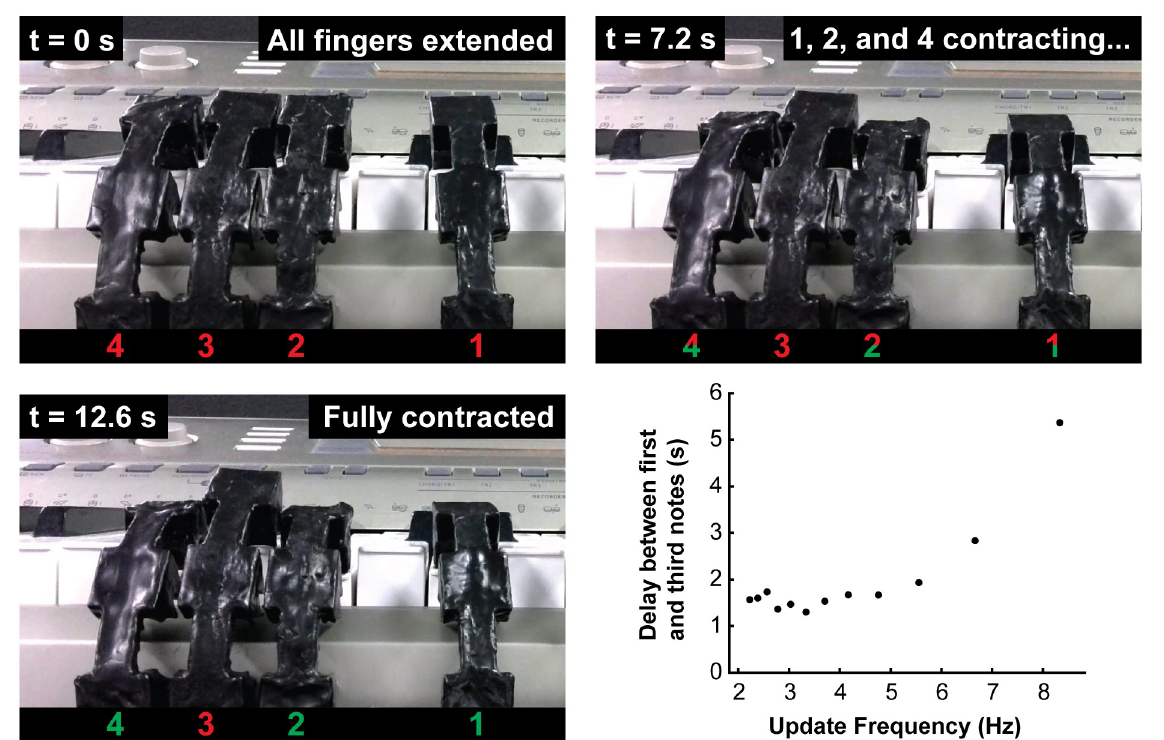
Fig 10. Video frames from using the pneumatic RAM and principles of time-division multiplexing (TDM) to control soft robotic fingers simultaneously playing the notes G, B, and D (a G-major chord) on an electric piano keyboard. The plot shows the observed delay between the start of the first note of the chord and the last note of the chord, as a function of the cycle speed of the pneumatic RAM. At cycle frequencies above 5.56 Hz the pneumatic RAM’s performance degrades and the chord’s notes do not sound simultaneously, but below 5.56 Hz the notes sound within 1 to 2 seconds of each